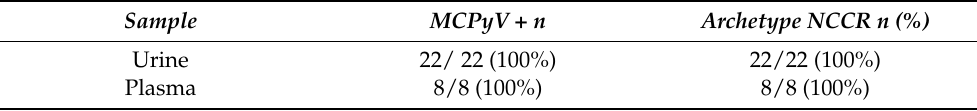
Table 7. Sequence analysis of MCPyV NCCR.